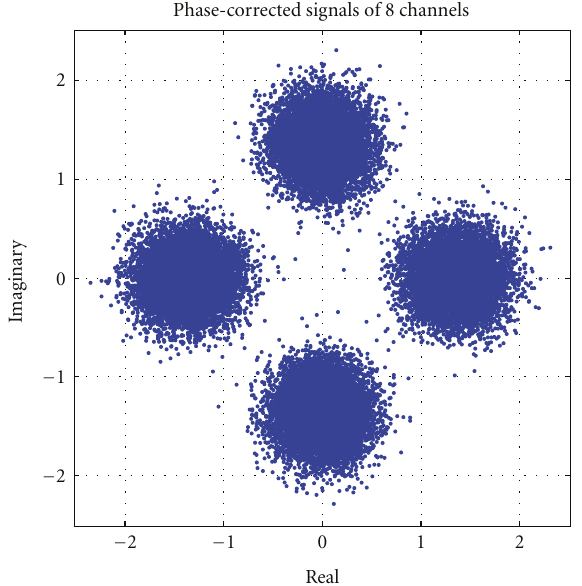
Figure 15: Scatter plot of phase-corrected QPSK symbols using eight channels in Unet06